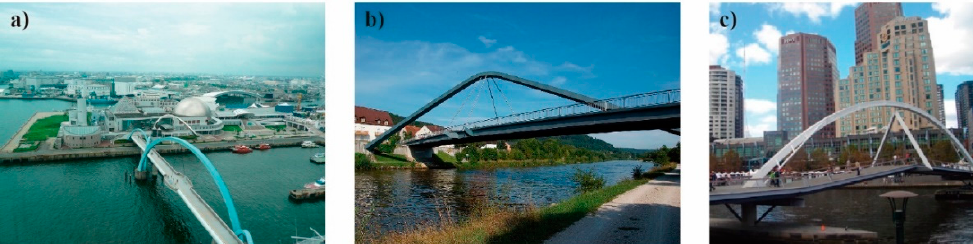
Figure 6. ( a ) Nagoya Port Footbridge (photo: Gnsin, Wikimedia Commons), ( b ) Plankstetten Bridge (photo: DALIBRI, Wikimedia Commons), and ( c ) Southgate Bridge (photo: Kevin Gibbons, flickr.com).